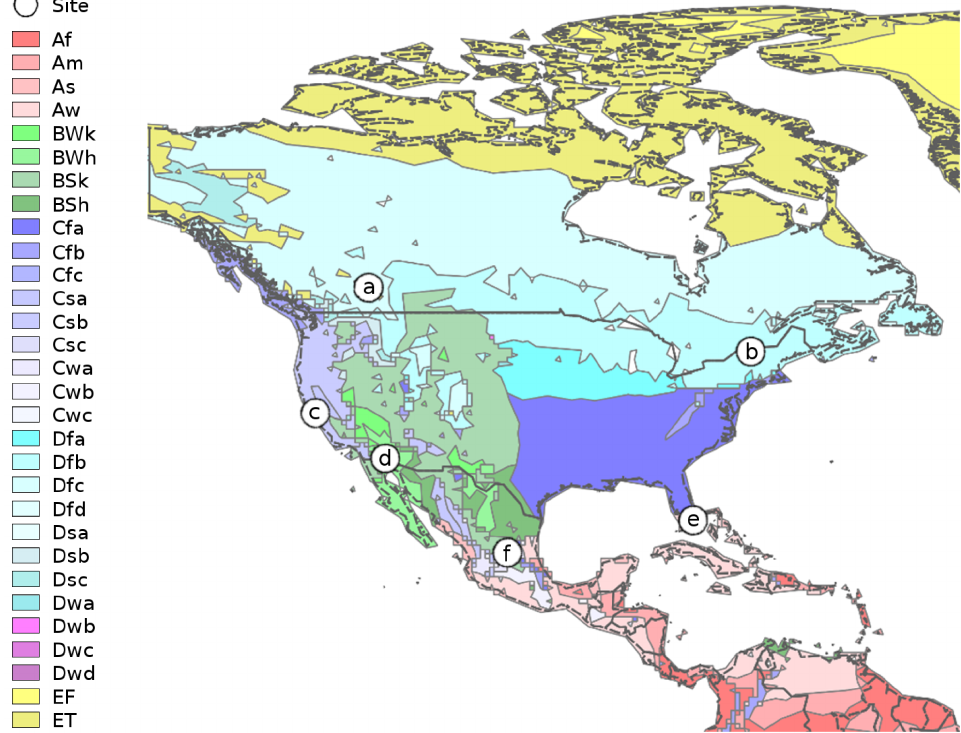
Figure 3. Map of Köppen–Geiger climate regions across North America (Kottek et al., 2006). Six locations are selected representing the following: (a) tundra – ET (51.8 ◦ N, 116.5 ◦ W; 1383ma.s.l.); (b) continental with warm summers – Dfb (44.7 ◦ N, 73.8 ◦ W; 383m.a.s.l.); (c) temperate with dry summers – Csb (37.8 ◦ N, 122.4 ◦ W; 16ma.s.l.); (d) hot arid desert – BWh (32.7 ◦ N, 114.6 ◦ W; 43ma.s.l.); (e) equatorial monsoon – Am (26.0 ◦ N, 80.3 ◦ W; 2ma.s.l.); (f) cold arid steppe – BSk (22.2 ◦ N, 101.0 ◦ W;